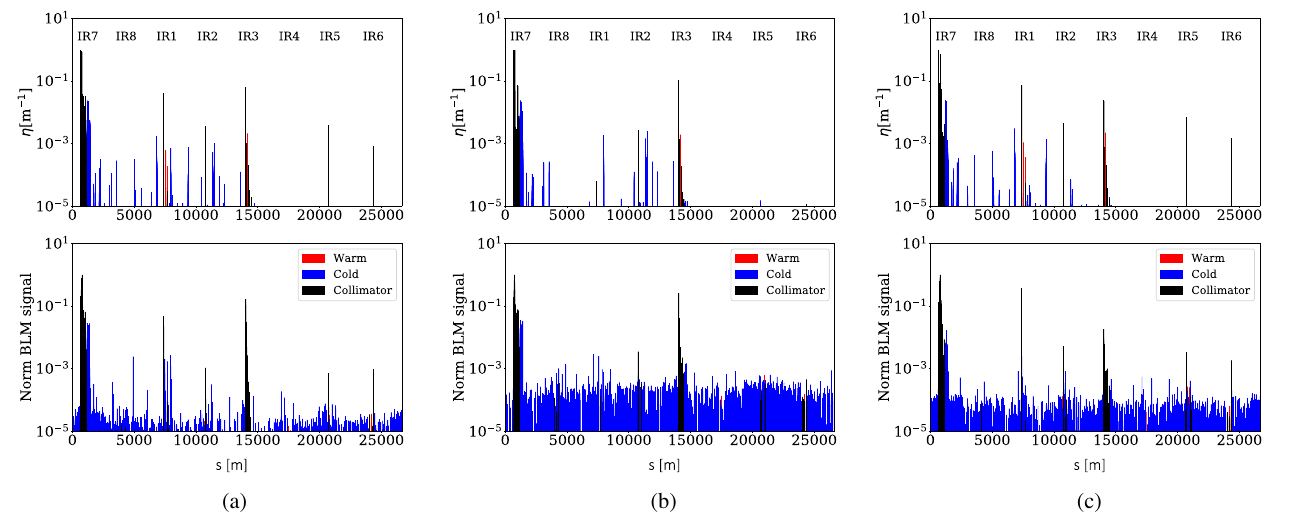
FIG. 8. Horizontal B1 simulated (top) and measured (bottom) loss map with both TCP jaws closed to 5 σ (a), with only the right TCP jaw closed to 5 σ (b) and with only the left TCP jaw closed to 5 σ